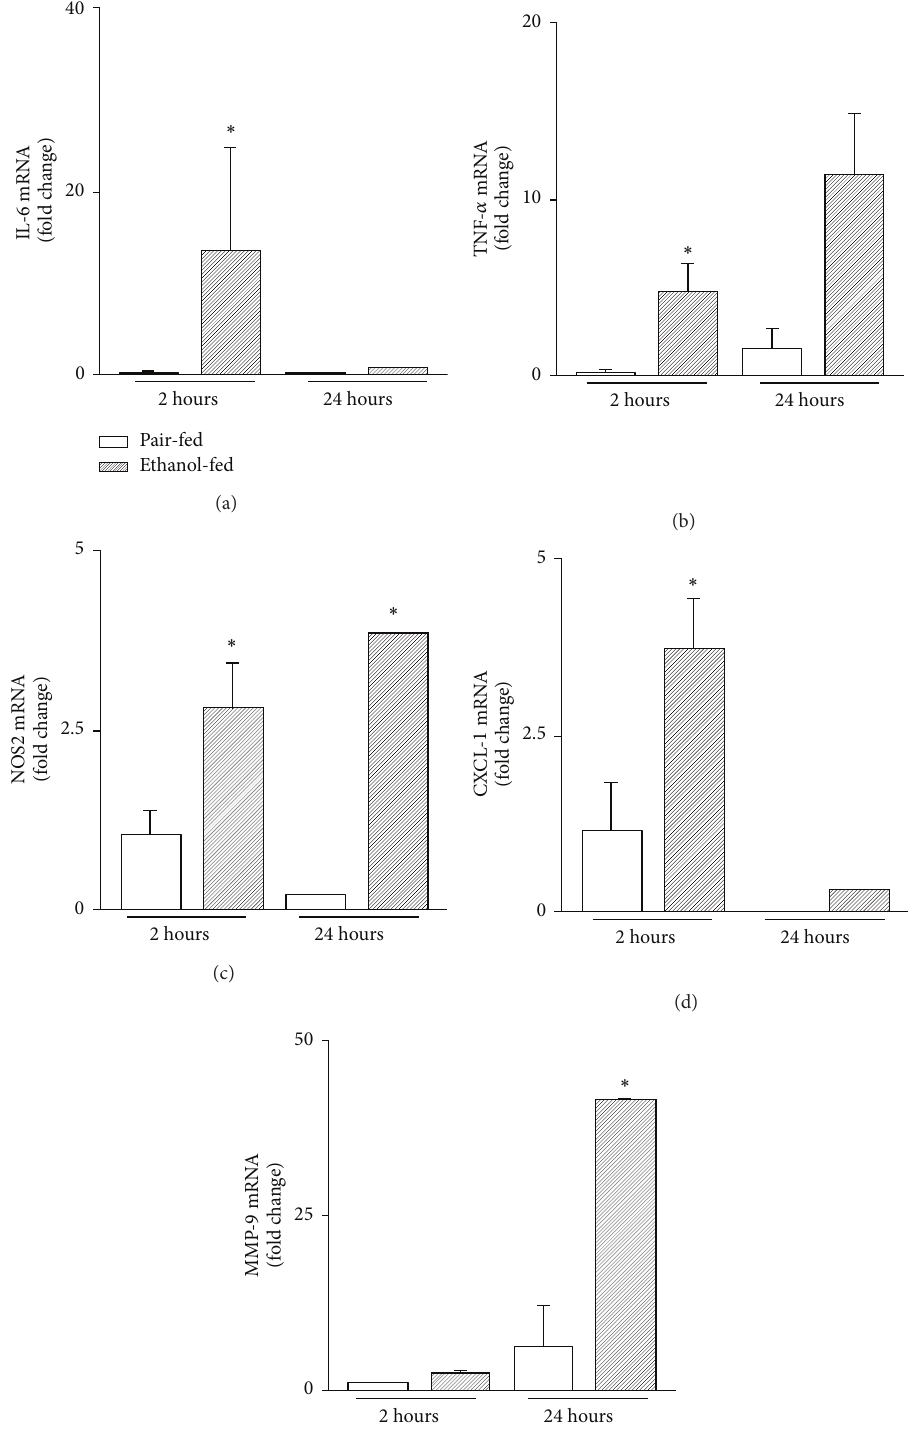
Figure 8: NF- 𝜅 B target gene expression in isolated Kupffer cells in response to TNF- 𝛼 after ethanol feeding F4/80 + macrophages were isolated from livers of ethanol-, pair-fed mice, respectively, and stimulated with TNF- 𝛼 (500 ng/mL) for 2h and 24 h. Supernatants were measured for mRNA levels of IL-6 (a), TNF- 𝛼 (b), NOS2 (c), CXCL-1 (d), and MMP-9 (e) by RT-PCR. Data (mean ± SEM) are expressed as fold change compared with corresponding medium controls (unstimulated) and are representative of five to eight separate experiments. ∗ 𝑃 < 0.05 versus pair-fed